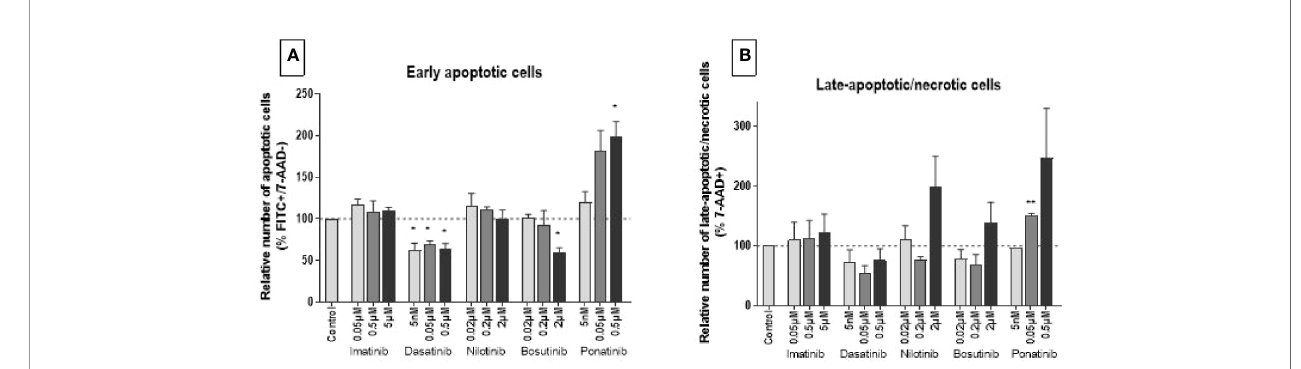
FIGURE 2 | Ponatinib induces HUVEC apoptosis and necrosis. HUVECs were labeled with Annexin V FITC and 7-AAD after exposure to BCR-ABL TKIs for 72 h in medium with 10% dialyzed FBS. The percentage of Annexin V + /7-AAD − and 7-AAD + cells revealed early apoptotic ( i.e. , cells exposing phosphatidylserine but with preserved membrane integrity) (A) and late-apoptotic/necrotic ( i.e. , cells with disrupted membrane integrity) (B) HUVECs, respectively. Bars represent the means of three experiments ± SEM. Results are expressed relative to control (DMSO 0.2%). Differences between conditions were tested using a one sample t-test that compared each TKI condition versus control. *p < 0.05 and **p